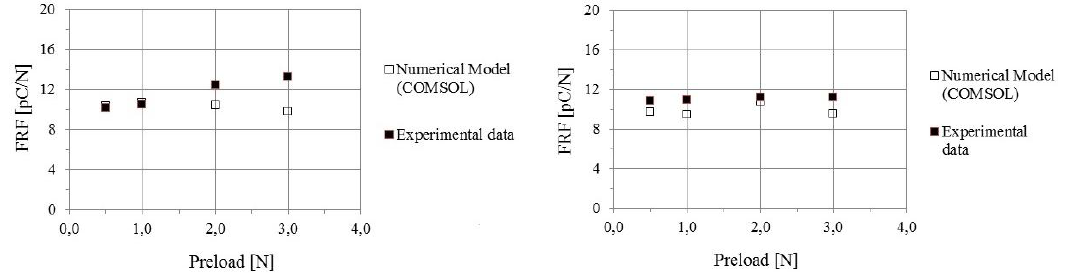
Figure 15. Single sensor analysis. A comparison is presented between numerical and experimental results for FRF vs. Preload, for 2 different indenters. Left : R = 4 mm, Right : R = 10 mm.